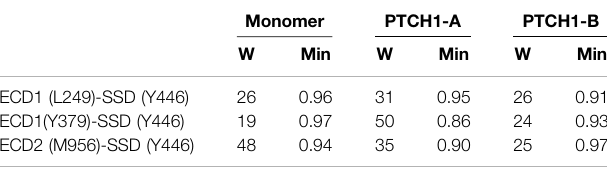
TABLE 2 | Properties of optimal paths in PTCH1 between the ECD and TMD. Monomer